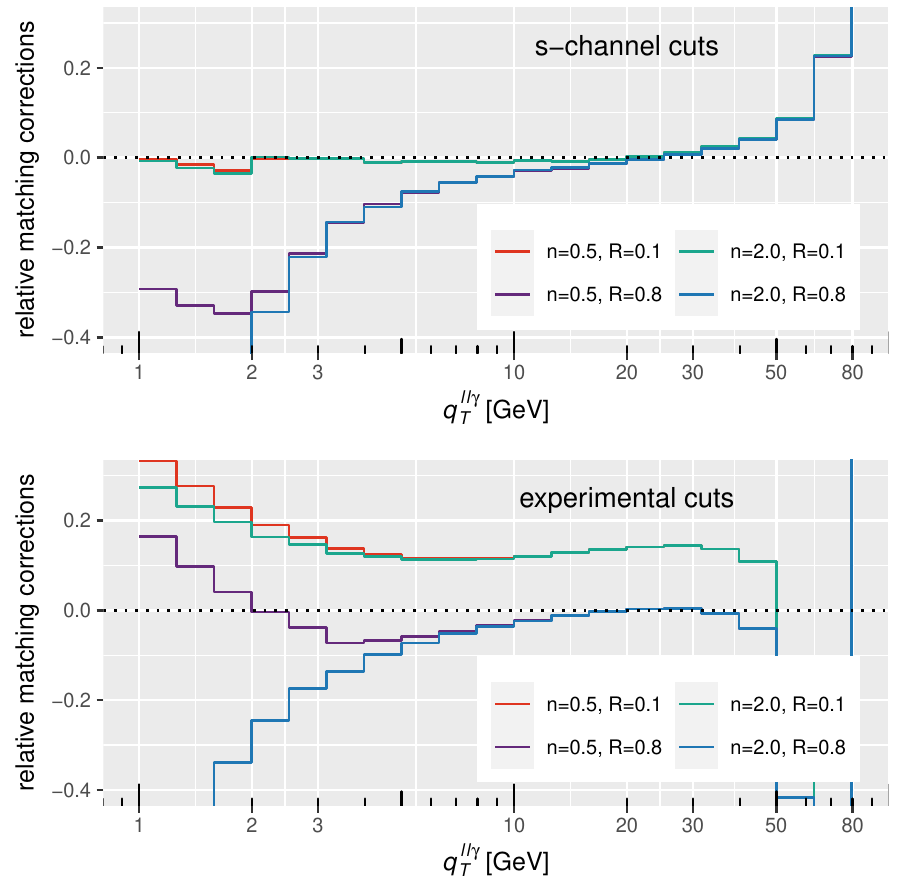
Figure 21. Matching corrections for Zγ production at N 2 LL , relative to the naively matched results for different choices of smooth-cone photon isolation parameters n and R 0 . The upper panel shows the results with s -channel benchmark cuts, see table 7. The lower panel is relevant for the experimental cuts that enhance the t -channel contribution, see table